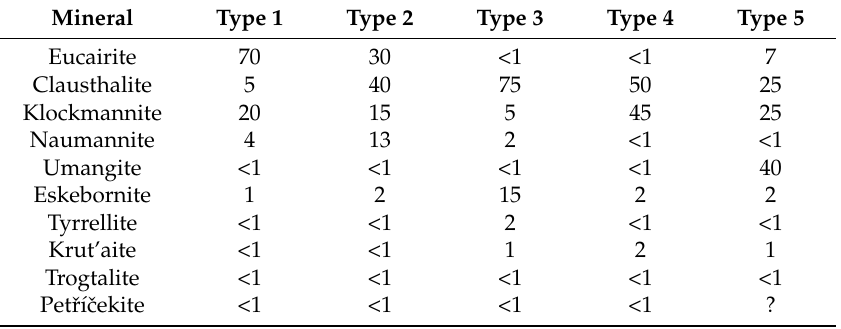
Table 1. Estimated modal percentages of selenides in the five types of Se veinlets.